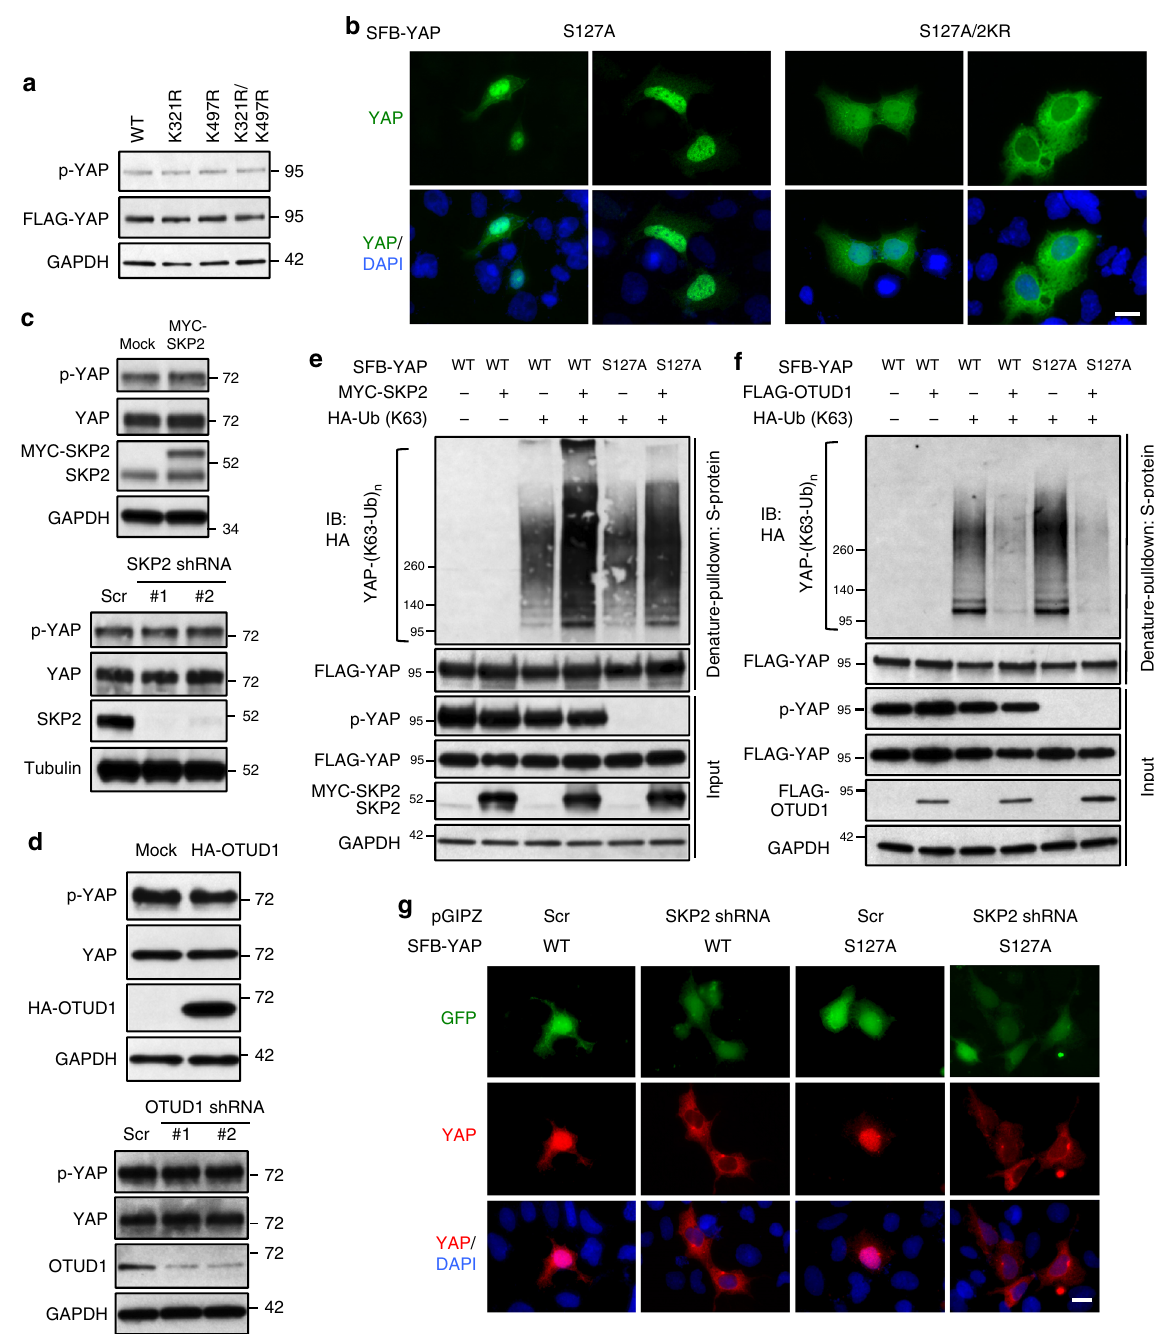
Fig. 6 K63-linked ubiquitination of YAP is independent of Hippo signaling-mediated YAP phosphorylation. a Immunoblotting of p-YAP (S127), FLAG-YAP, and GAPDH in HEK293T cells transfected with SFB-YAP (wild-type, K321R, K497R, or K321R/K497R). b YAP knockout HEK293A cells (generated by CRISPR-Cas9) were transfected with SFB-YAP (S127A or S127A/K321R/K497R) and immunostained with a YAP-speci fi c antibody (green). DAPI (blue) was used to stain DNA. Two different fi elds are shown. Scale bar, 20 μ m. c Immunoblotting of p-YAP (S127), YAP, and SKP2 in HEK293A cells stably expressing MYC-SKP2 ( upper panel) or SKP2 shRNA ( lower panel). Scr: a scramble control. d Immunoblotting of p-YAP (S127), YAP, OTUD1, and GAPDH in HEK293A cells stably transfected with HA-OTUD1 (upper panel) or OTUD1 shRNA (lower panel). Scr: a scramble control. e HEK293T cells were co-transfected with SFB-YAP (wild-type or S127A), MYC-SKP2 and the K63-speci fi c mutant of HA-ubiquitin and then subjected to a pulldown assay with S-protein beads and immunoblotting with antibodies against HA and FLAG. f HEK293T cells were co-transfected SFB-YAP (wild-type or S127A), FLAG-OTUD1 and the K63-speci fi c mutant of HA-ubiquitin and then subjected to a pulldown assay with S-protein beads and immunoblotting with antibodies against HA and FLAG. g YAP knockout HEK293A cells (generated by CRISPR-Cas9) were transfected with SFB-YAP (WT or S127A) with or without SKP2 shRNA (on a GFP-positive pGIPZ vector), and immunostained with a YAP-speci fi c antibody (red). DAPI (blue) was used to stain DNA. Scr: a scramble control. Scale bar, 20 μ